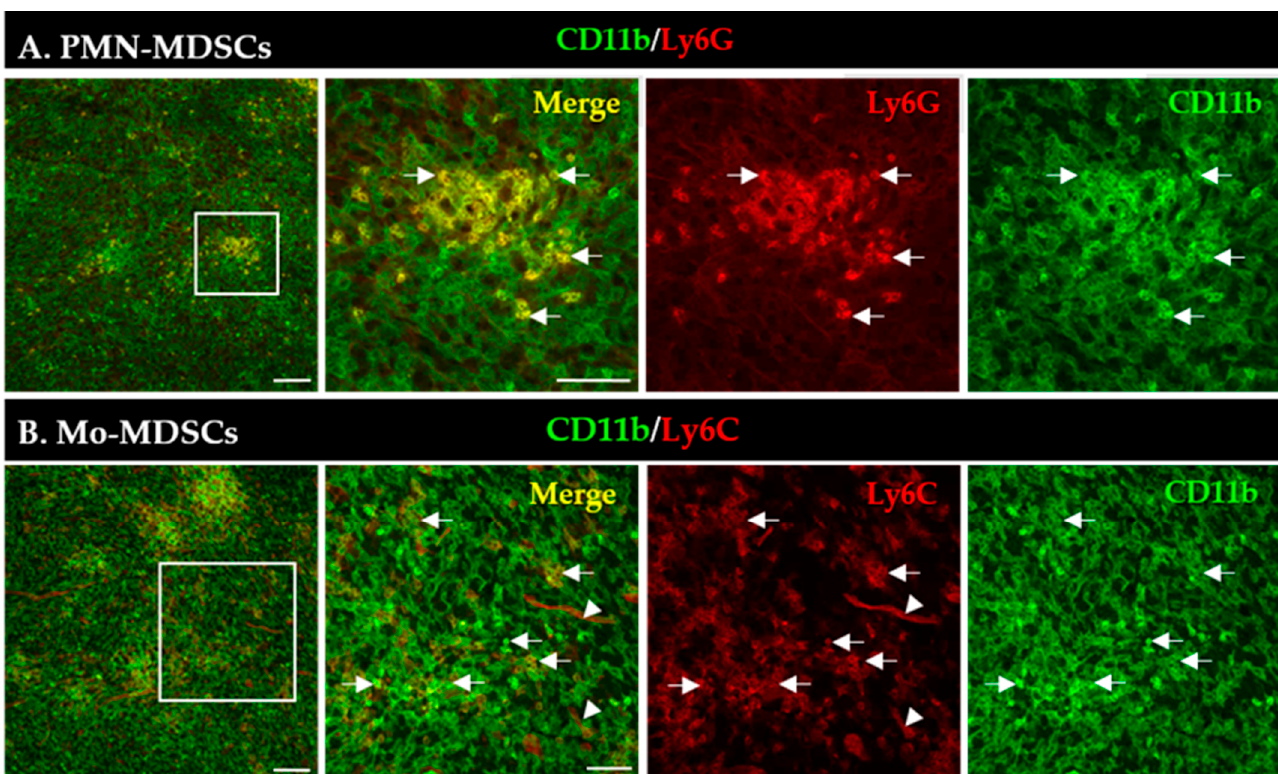
Figure 1. Detection of PMN-MDSCs ( A ) and Mo-MDSCs ( B ) cells in LLC cryosections by immunofluorescence. Staining with CD11b-specific antibody marks all myeloid cells (green), while co-staining with Ly6G ( A ) and Ly6C ( B ) antibodies (red) reveals PMN-MDSCs and Mo-MDSCs (arrows), respectively. Labels in the top right corner of the panels indicate the images obtained with filter settings specific for individual fluorophores or the merged image. Arrowheads mark blood vessels stained with the Ly6C antibody. Boxed areas in the left images are shown in higher magnification to the right panels. Scale bars are 100 µ m for the low and 50 µ m for higher magnification